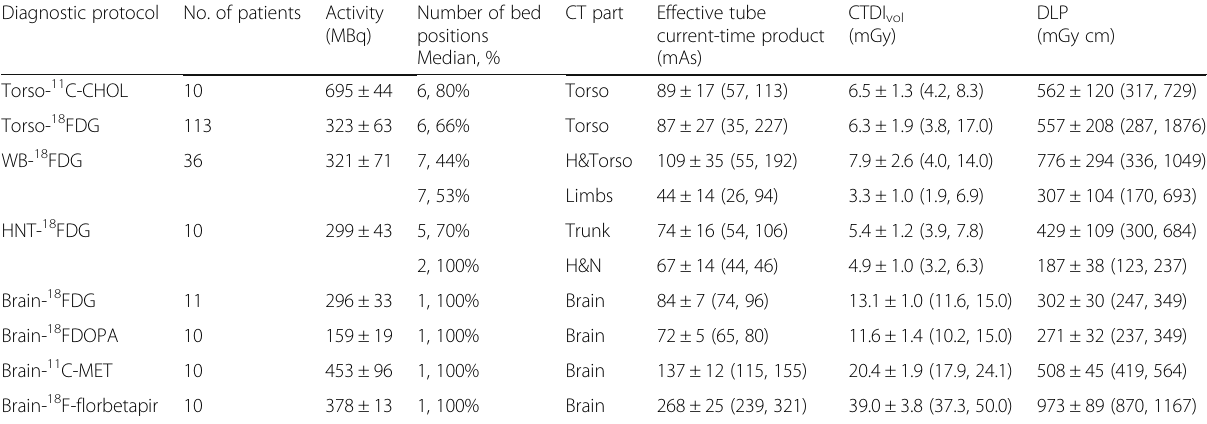
Table 3 PET scan parameters and CT exposure parameters for each protocol Diagnostic protocol No. of patients Activity (MBq)